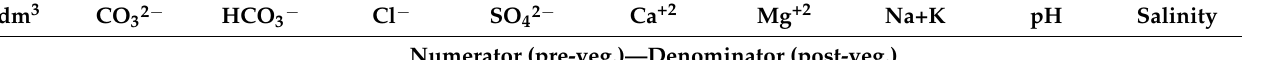
Table 4. Correlation between chemical parameters of groundwater.